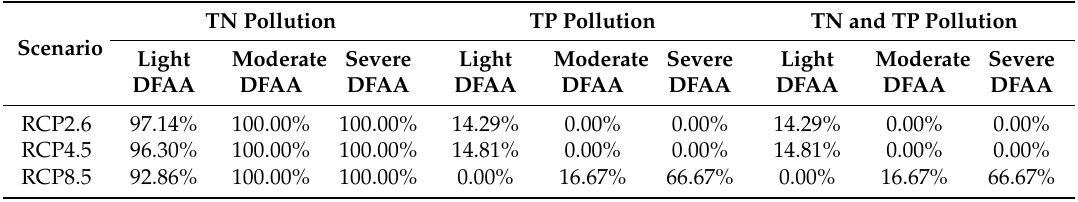
Table 9. The incidence of water pollution (%) in Class III under different DFAA